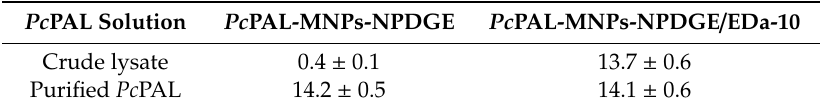
Table 2. Comparison of Pc PAL immobilization from crude lysate or from pure enzyme solution using epoxy and optimized mixed epoxy-chelate MNPs as support [ U B ( µ mol × min − 1 × g − 1 )].